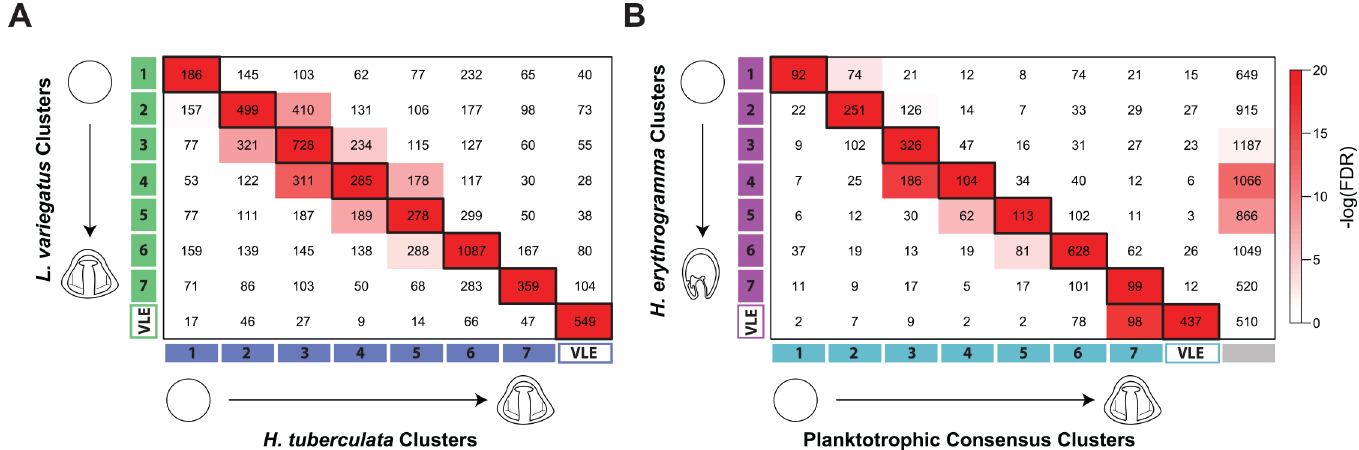
Fig 5. Genes coexpressed during planktotrophic development significantly overlap with those coexpressed during lecithotrophic development. (A) Overlap matrix of H . tuberculata and L . variegatus cluster assignments (S1 Table). The x -axis represents H . tuberculata clusters, and the y -axis represents L . variegatus clusters. Each cell contains the number of intersecting genes, and the cell color represents the significance of the intersection. Cells along the matrix diagonal are “ consensus clusters ” between the planktotrophic species (e.g., consensus cluster 1 contains 186 genes that are coexpressed in both H . tuberculata cluster 1 and L . variegatus cluster 1). Consensus cluster cells are outlined in black. In general, genes coexpressed below the matrix diagonal represent genes that have accelerated expression profiles in H . tuberculata compared to L . variegatus , whereas genes coexpressed above the matrix diagonal represent genes that have delayed expression in H . tuberculata compared to L . variegatus . (B) Overlap matrix of planktotrophic consensus cluster and H . erythrogramma cluster assignments (S1 Table). The x -axis represents planktotrophic consensus clusters (detailed in A ), except for the grey cluster, which represents genes that did not exhibit consensus expression profiles between planktotrophs (i.e., genes that were off-diagonal in A ). The y -axis represents H . erythrogramma clusters. Each cell contains the number of intersecting genes, and the cell color represents the significance of the intersection. Cells along the matrix diagonal are coexpressed between all three species and are outlined in black. In general, genes coexpressed below the matrix diagonal represent genes that have accelerated expression profiles in the planktotrophs compared to H . erythrogramma , whereas genes coexpressed above the matrix diagonal represent genes that have delayed expression in the planktotrophs compared to H . erythrogramma .